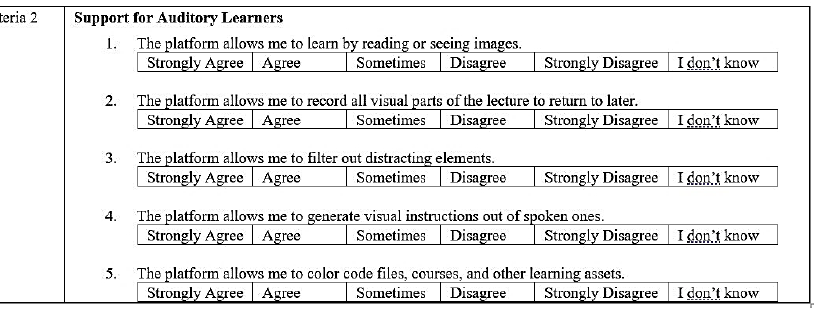
Fig. 4. Learning style accommodation question